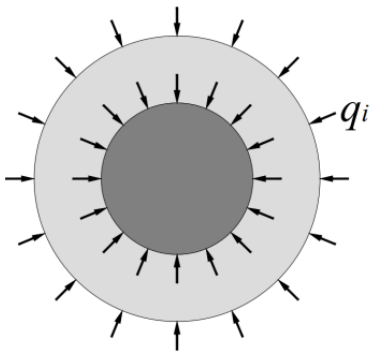
Figure 3. Stress analysis for cross section.